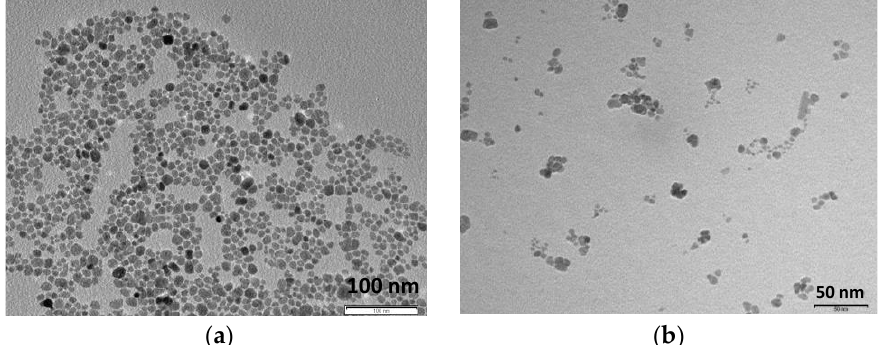
Figure 11. TEM images of magnetite NPs coated with ( a ) aminolauric acid and ( b ) polyacrylic acid (PAA).